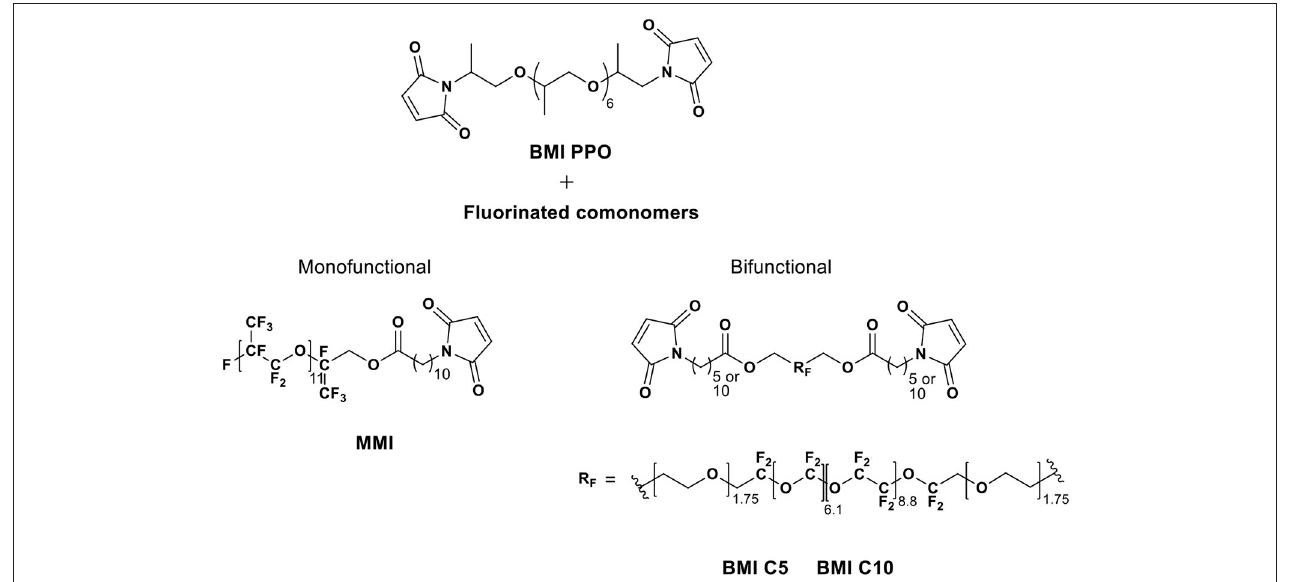
FIGURE 1 | Structures of BMI PPO and the different comonomers maleimide